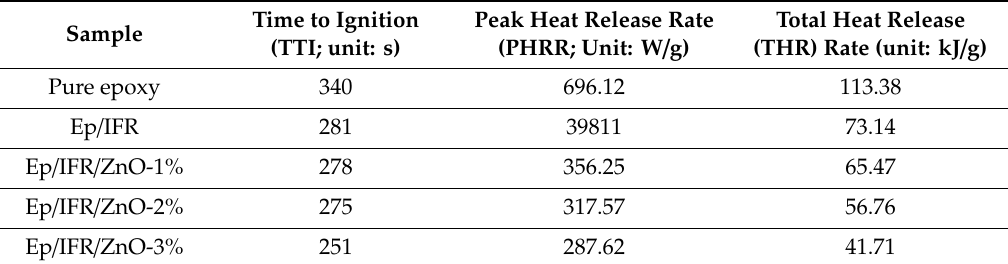
Figure 11. Peak heat release rate curves of the pure poxy, Ep / IFR, Ep / IFR / ZnO-1%, Ep / IFR / ZnO-2%, and Ep / IFR / ZnO-3% samples. Table 4. Cone calorimeter results of the coatings. Sample